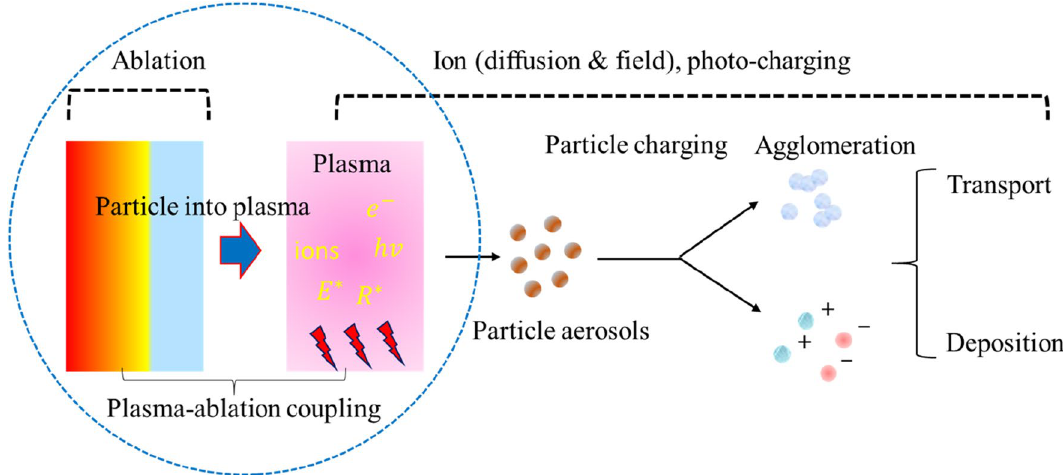
Figure 10. Schematic showing the mechanisms of plasma-ablation plume coupling, charging of particle aerosol in the plasma, and agglomerates